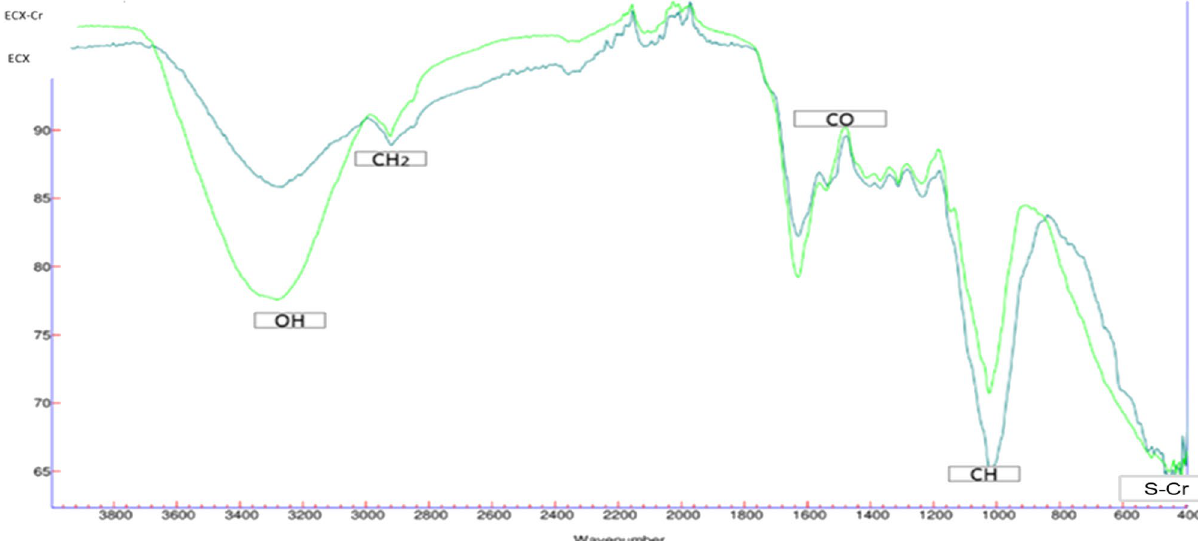
Figure 1. FTIR of ECx before and after of adsorptions of Cr